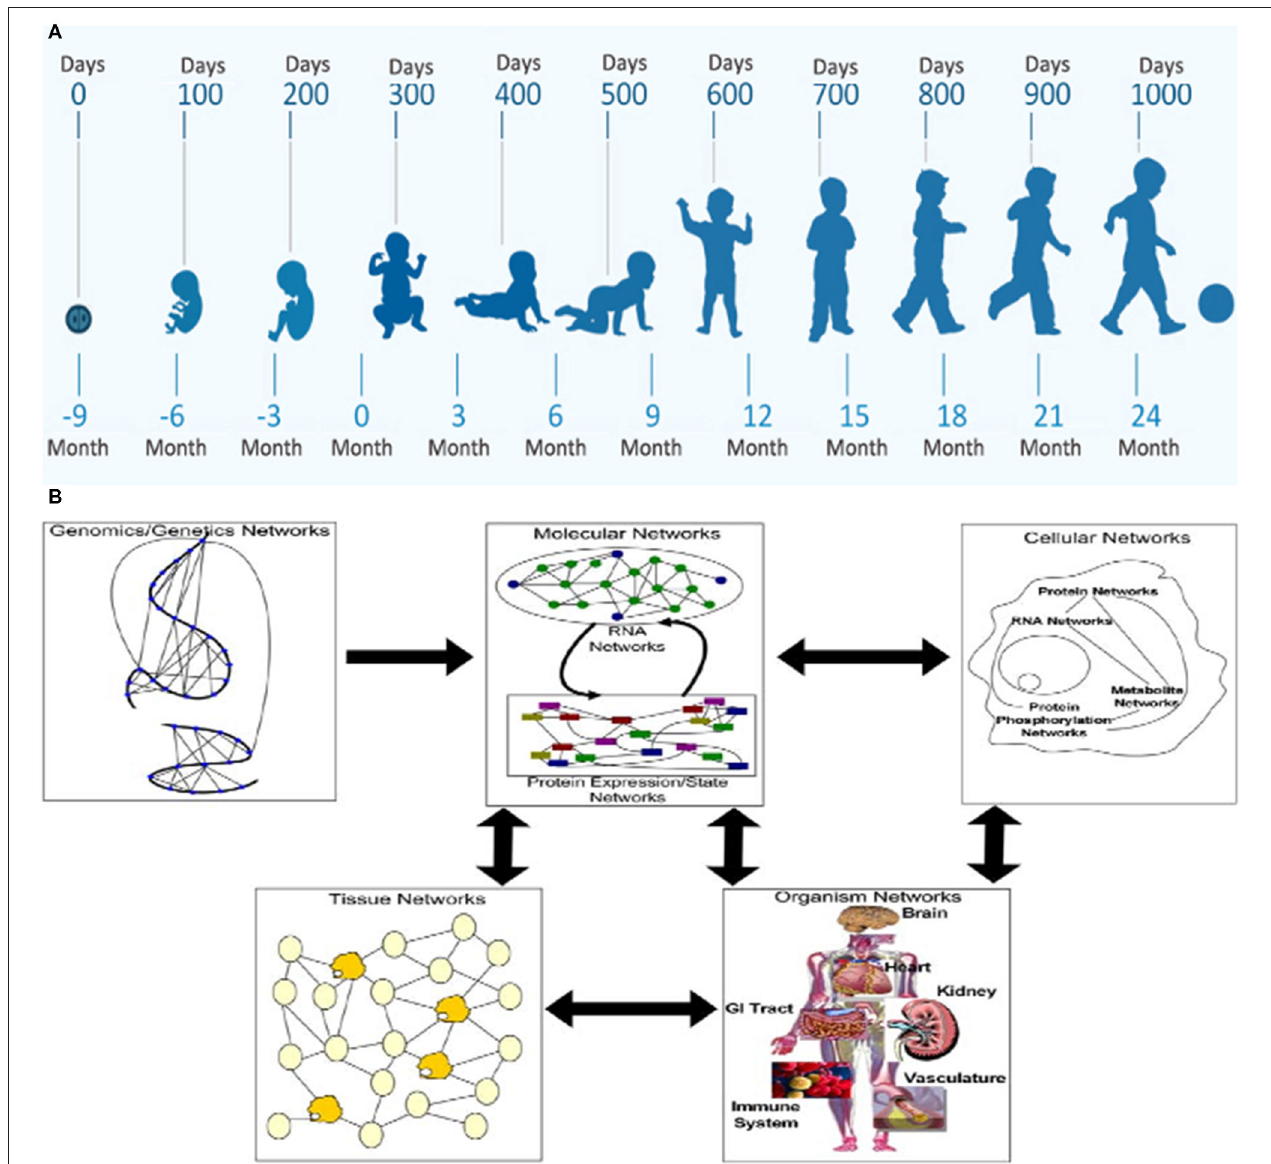
FIGURE 1 | The horizontal/vertical diagnostic process across maturing phenotypes over the first 1,000 days: (A) WHO program diagram depicts the horizontal perspective over the first 1,000 days from conception through 2 years of age. (B) The vertical diagnostic perspective depicts the flow of information across biological systems through a hierarchy of networks. Each panel highlights a different set of networks at play in a biological system. Genomics networks represent interactions among DNA sequences that may give rise to longer-range as well as more local chromosome structures that modulate gene activity, in addition to inducing synergistic effects on higher-order phenotypes. Genomics networks drive molecular networks composed of RNA, protein, metabolites, and other molecules in the system. Molecular networks are components of cellular networks in which the complex web of interactions among these networks gives rise to the complex phenotypes that define living systems. Tissue networks comprise cellular networks that are clearly influenced by the molecular and genomics networks, and organism networks comprise tissue networks that are clearly defined by the component cellular and molecular networks. Complex phenotypes like disease emerge from this complex web of interacting networks, given genetic and environmental perturbations to the system